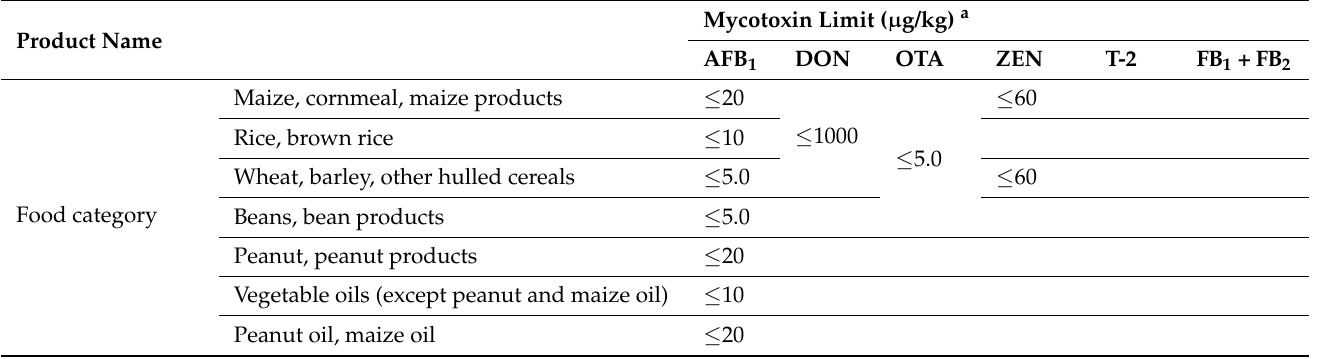
Table 3. Maximum tolerable level of mycotoxins in cereals and other agricultural commodities in